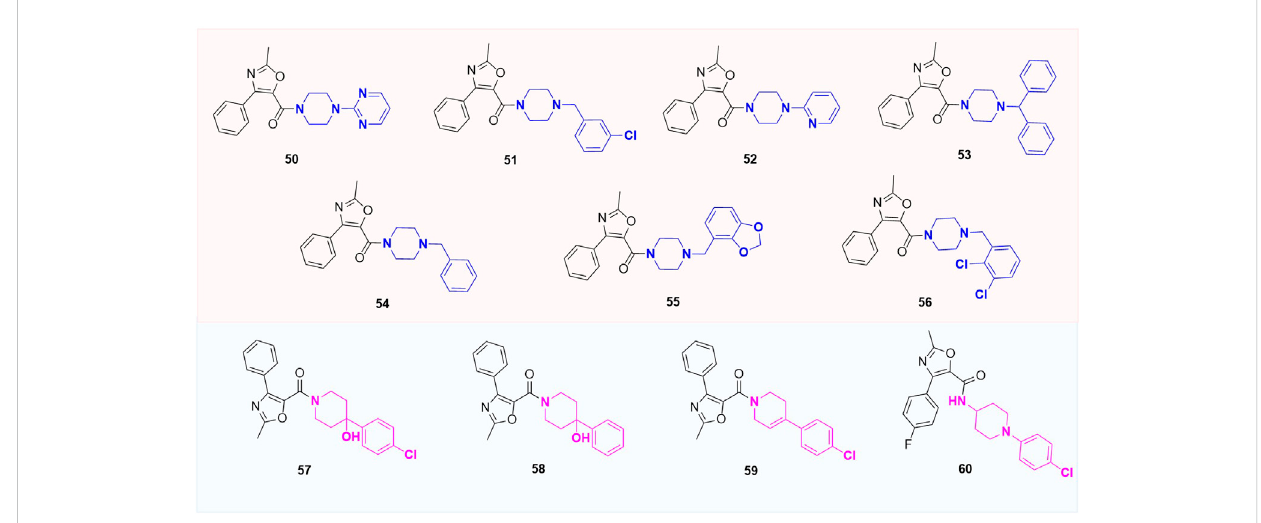
FIGURE 11 Structure of aryl piperidine analogues.